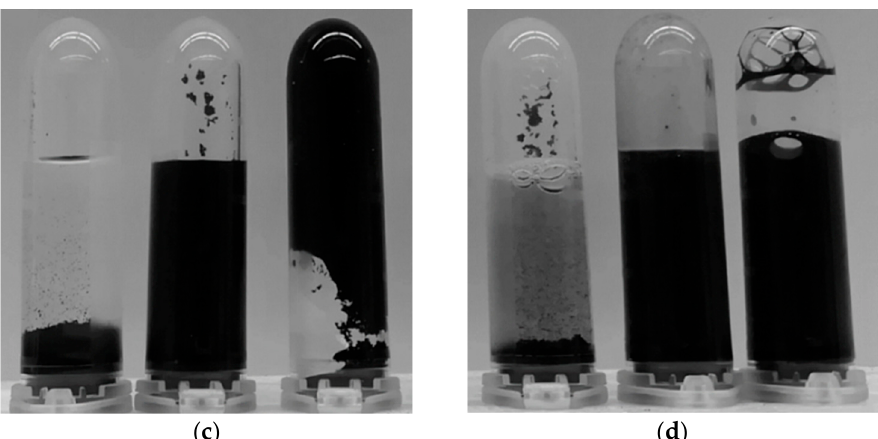
Figure 4. Ultrasonic impact on CNT suspensions: ( a ) 0.4 g CNTs in 40 mL DI-water, no ultrasonic impact; ( b ) 0.4 g CNTs in 40 mL DI-water, ultrasonic impact (20%, 6 min, 10 s on, 15 s off) ( c ) 0.4 g in 40 mL DI-water after different times of US (20%, 10 s on, 15 s off): l.t.r.: 0 min (prompt sedimentation), 3 min (more viscous), 6 min (highly viscous, gel-like); ( d ) 0.4 g CNTs in 10 mL 10 g L − 1 SDBS after different times of US (20%, 10 s on, 15 s off): l.t.r.: 0 min (prompt sedimentation), 3 min (dispersed system), 6 min (dispersed system).